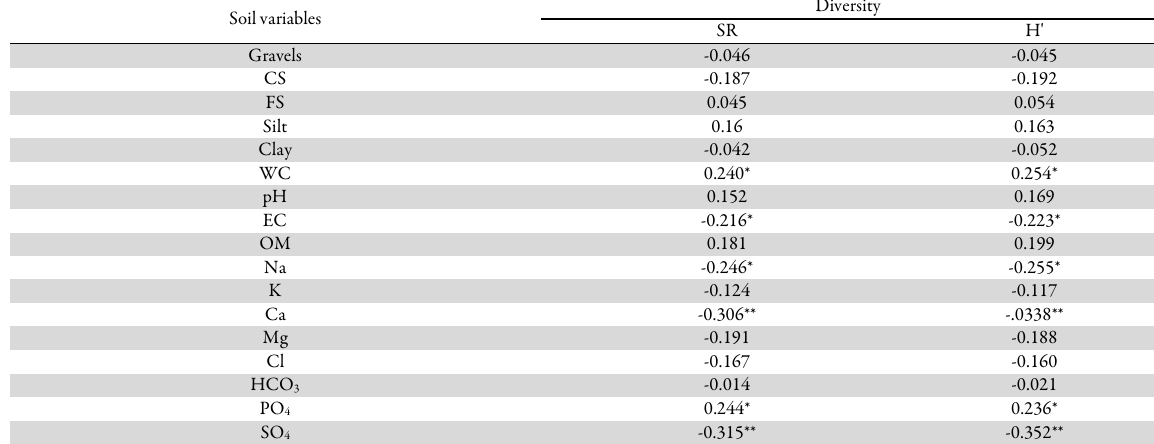
Table 4. Spearman rank correlations between diversity indices and the environmental variables (*= p <0.05, **= p <0.01) (for soil abbreviations, see Table